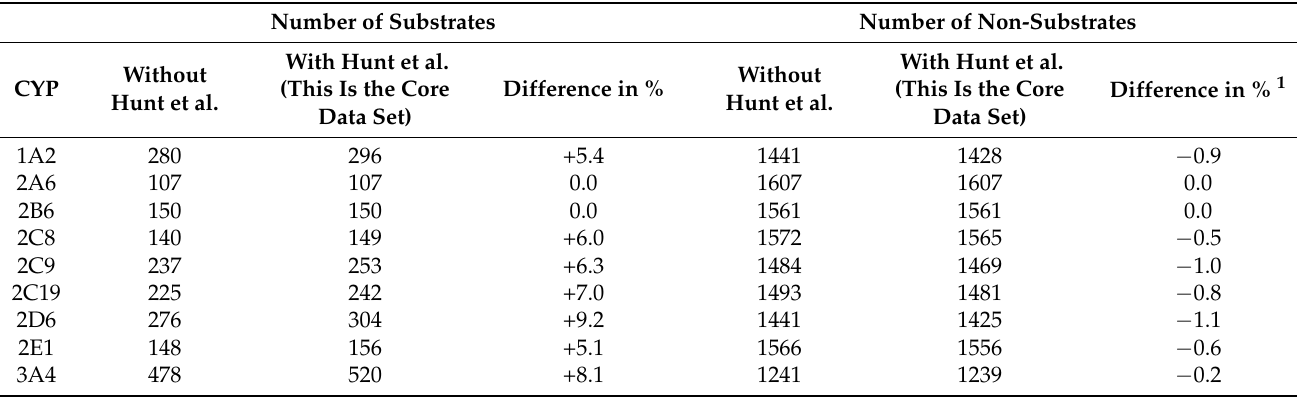
Table 1. Distribution of substrates and non-substrates in the core data set in comparison to a version that does not make use of the data of Hunt et al. [13]. 1 In some cases, the merging of the data from Tian et al. and Hunt et al. did in fact lead to a reduction in the number of non ‐ substrates. This is because of inconsistencies identified in the bioactivity labels of compounds present in both data sets. Any compounds with conflicting activity labels were rejected during data processing (see Section 3 Materials and Methods for details). CYP Hunt et al.